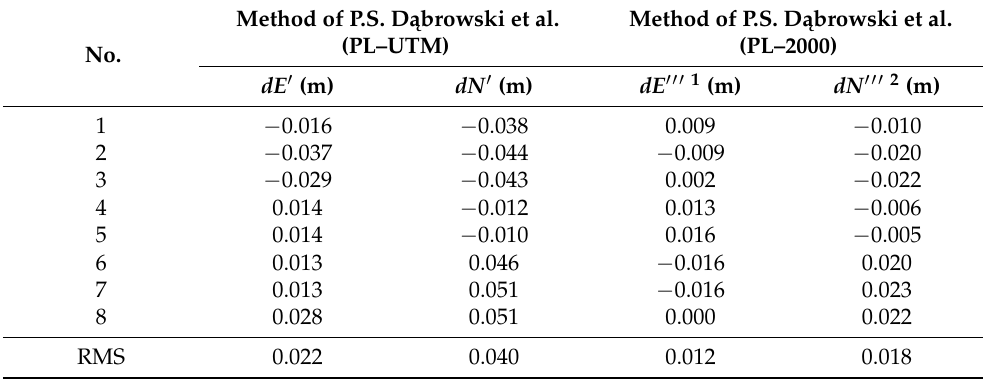
Table 12. Absolute error values of the measurement point coordinates in the PL–UTM and PL–2000 systems determined by the method of P.S. D ˛abrowski et al.